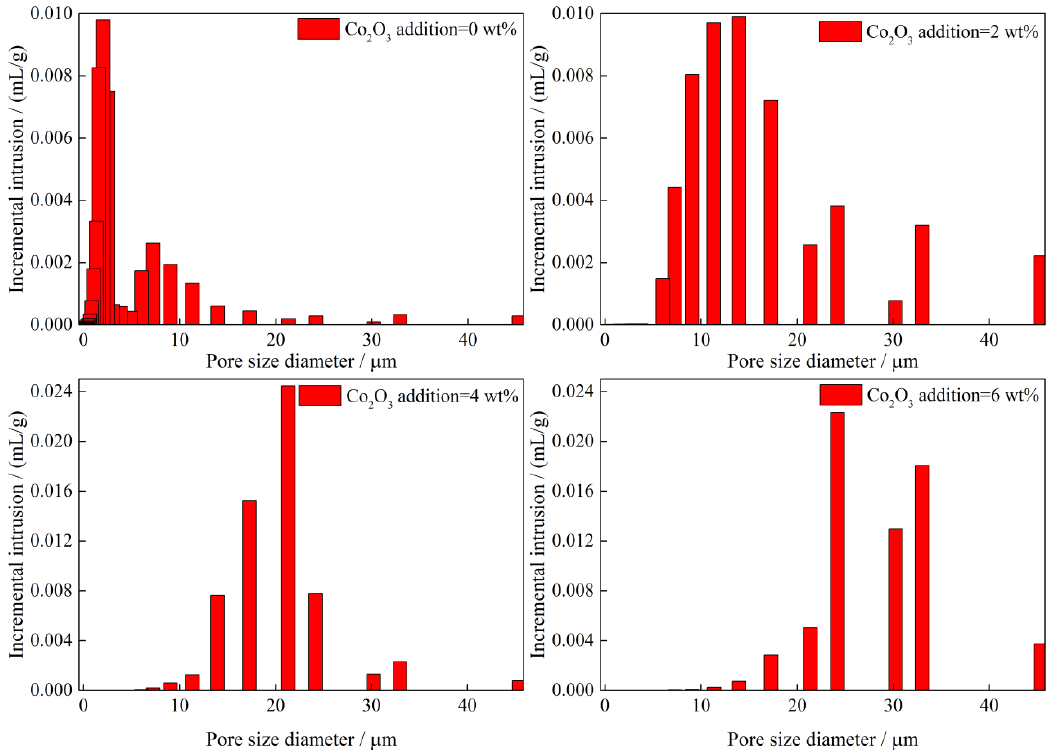
Figure 7. Porosity and pore size distribution of CVTP with Co 2 O 3 additions: ( a ) 0 wt %, ( b ) 2 wt %, ( c ) 4 wt %, and ( d ) 6 wt %.